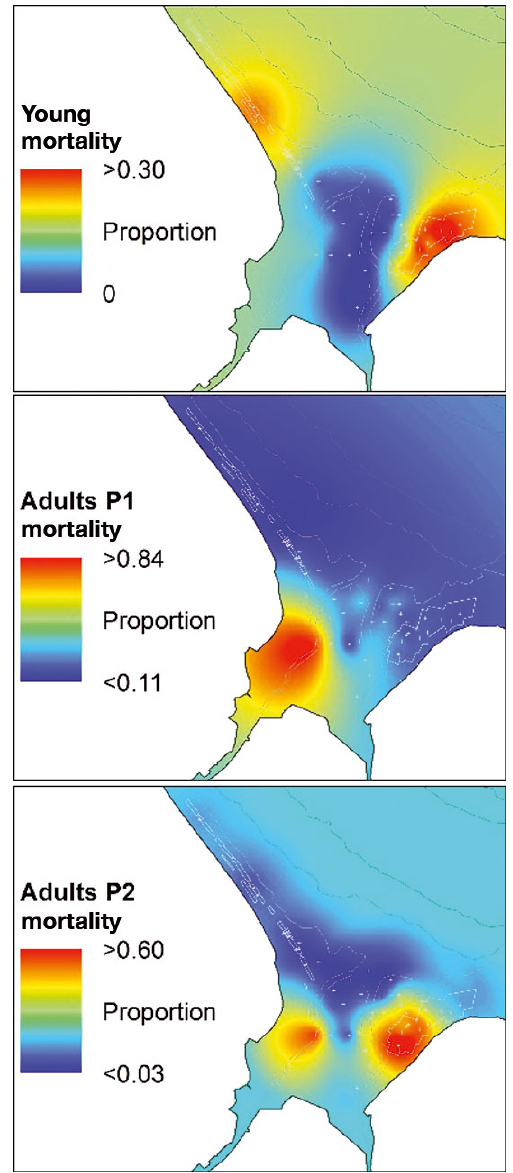
Fig. 4. Co-kriged maps of predicted Pacific oyster mortality (young, and adults during Period 1 and Period 2). Co-kriging variables were: connectivity to the Grandcamp farming area (May) and chlorophyll a for young oysters; connectivity to the Carentan channel (February) and salinity for adults during Period 1; and connectivity to the Grandcamp farming area (August) and salinity for adults during Period